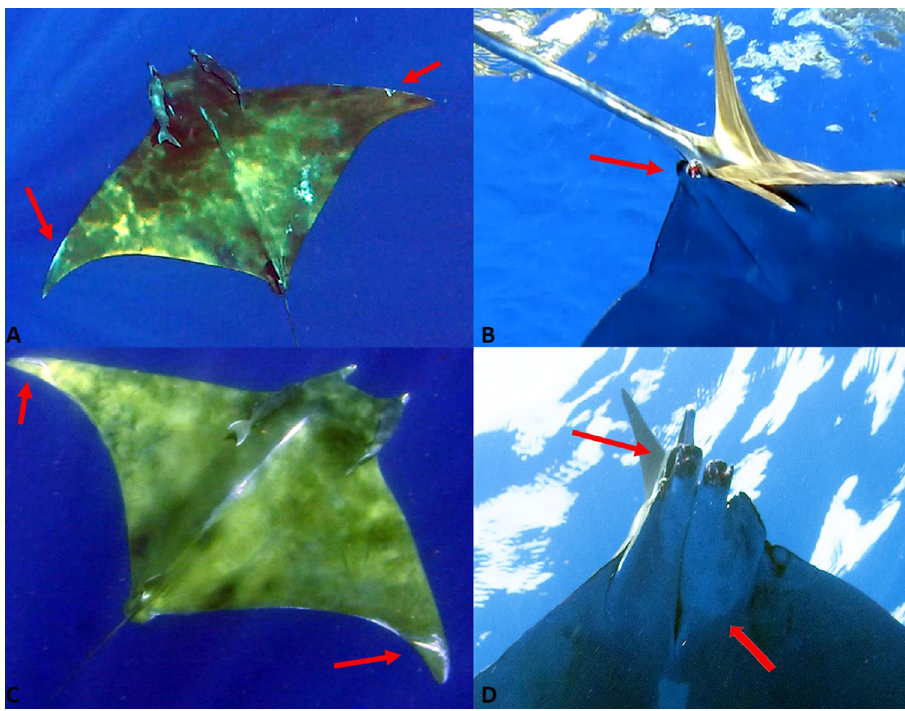
FIGURE 4 | Mobula tarapacana observed in the Saint Peter and Saint Paul Archipelago. Left panel- females with evidence of mating scars on pectoral fins. Right panel- males with evidences of mating on the claspers (swollen and/or